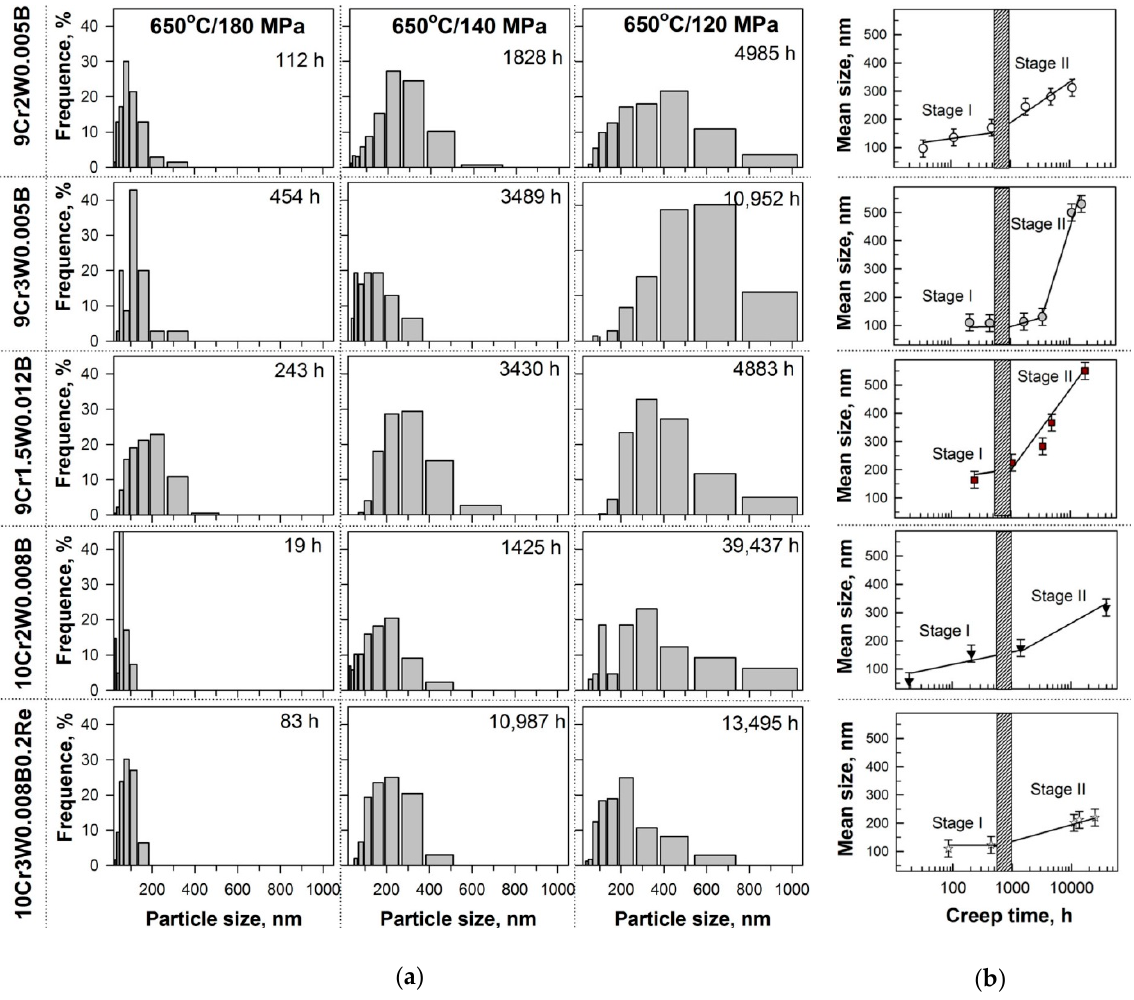
Figure 7. ( a ) Size distribution of Laves phase particles for the steels studied after some creep rupture tests corresponding to the region of the short-term creep (180 MPa), the transition region (140 MPa), and the region of long-term creep (120 MPa), numbers indicate the rupture time; ( b ) change in the mean size of Laves phase particles with creep time in the steels that is subdivided into two stages of growth.